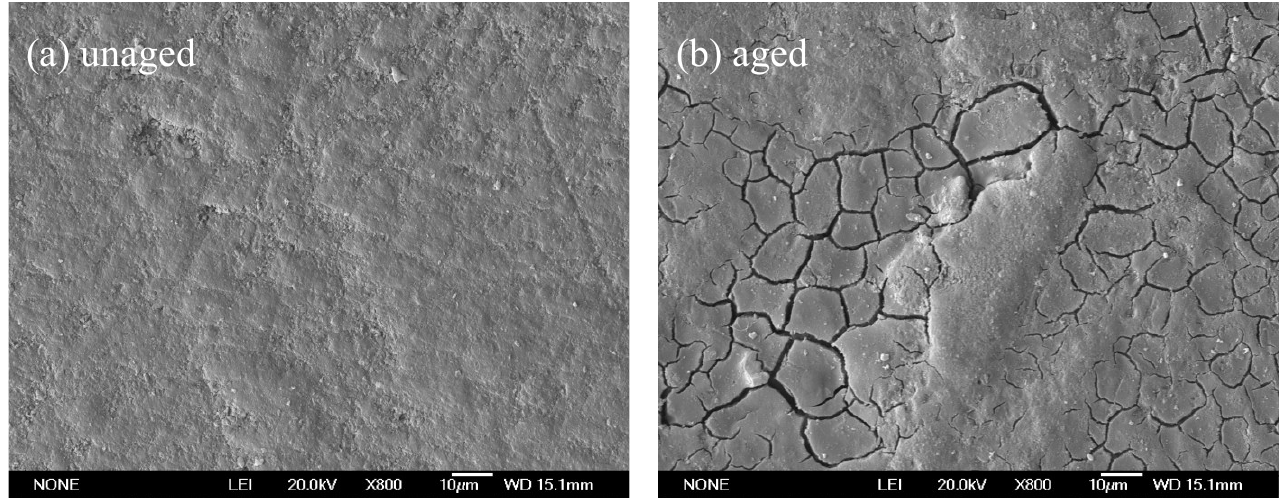
Figure 5. The SEM photograph of the surface of the composite coating with 6 wt.% spherical alu- minum powder before and after 100 days UV irradiation: ( a ) unaged composite, ( b ) aged compo- site.